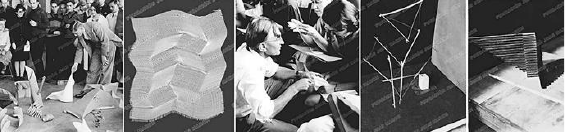
Figure 2. Hands-on activities in the Bauhaus system (Albers,